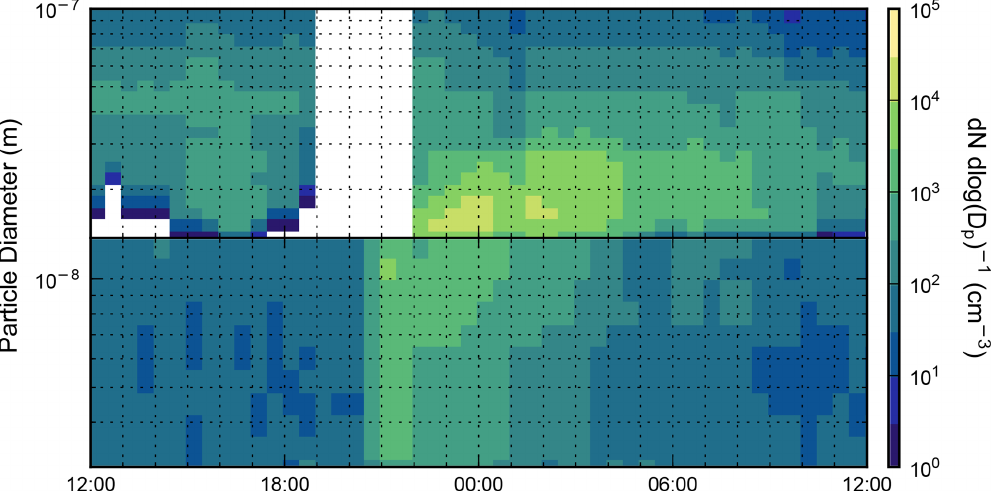
Figure 19. Same as Fig. 16b and c but for 1d only. On 1 February 2018 at approximately 21:00UTC, a new particle formation event that was detected by the SMPS (top) and NAIS (bottom)